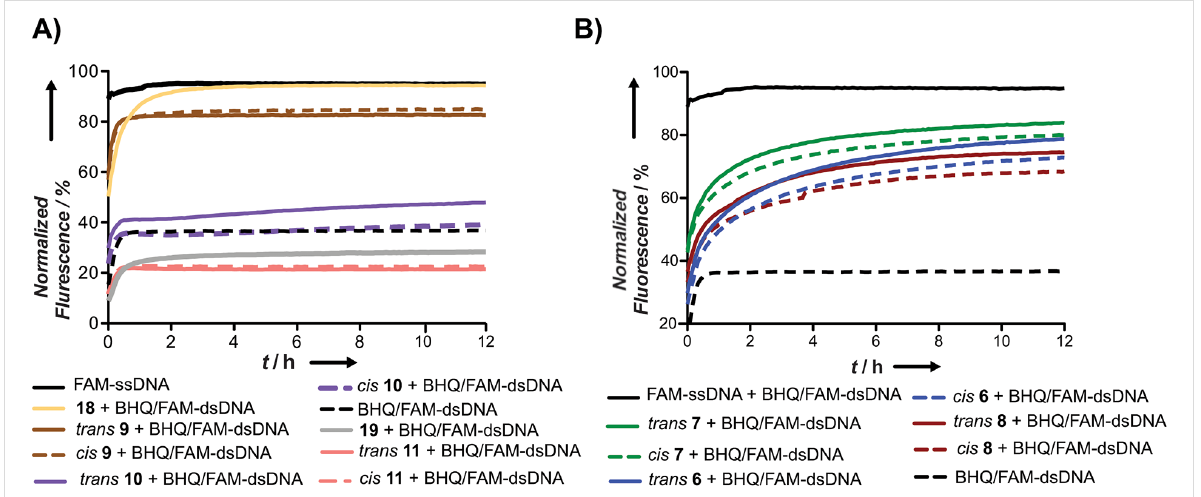
Figure 5: Time-dependent fluorescence signals from two independent experiments at 520 nm of 0.75 μ M FAM/BHQ-dsDNA solutions in PBS buffer (140 mM NaCl, 10 mM Na 2 HPO 4 , 2.7 mM KCl, 1.8 mM KH 2 PO 4 , pH 8.0) with 2 equiv of the corresponding PNAs 6 – 11 , 18 and 19 placed in 96-well plates and covered with paraffin oil; fluorescence intensities were measured every 5 min during 12 h at 30 °C; PNA code: 6 : blue, 7 : green, 8 : maroon, 9 : brown, 10 : purple, 11 : coral, 18 : yellow and 19 : gray; solid line for trans- isomers and dashed line for cis- isomers. Black lines controls: solid: FAM-ssDNA without PNA and under the same conditions; dashed: